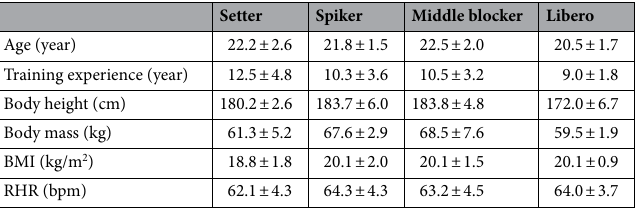
Table 1. Characteristics of the subjects (n = 24). BMI body mass index, RHR resting heart rate.